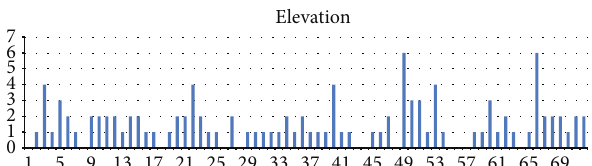
Figure 7: Value of “elevation” that adjust the old baseline wander to form the new one for all 72 subjects.